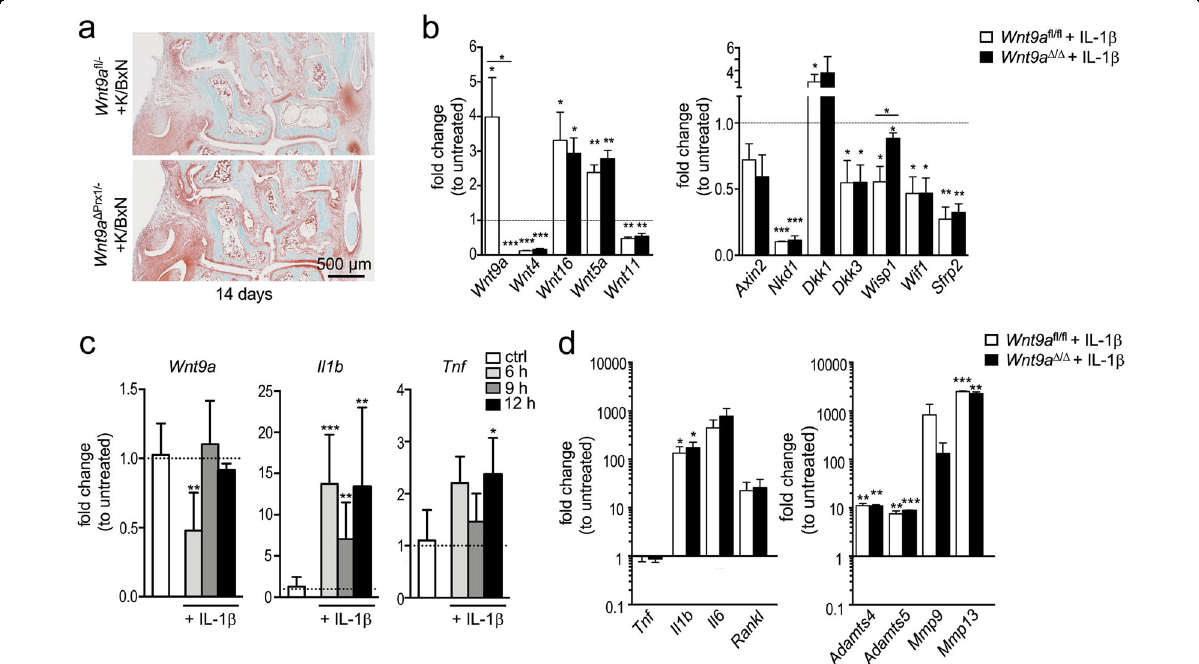
Fig. 6 Histological assessment of K/BxN-treated mice and alterations in gene expression levels in Wnt9a fl / fl and Wnt9a -de fi cient cells in response to IL-1 β treatment. a Representative images of Safranin O stained tarsal joint sections of the 14-day timepoint ( n = 3). b qPCR analysis of Wnt genes and Wnt pathway-related genes in Wnt9a f l/ fl and Wnt9a -de fi cient SFBs after treatment with recombinant murine IL-1 β . c qPCR analysis of short-term effects on the expression of Wnt9a, Il1b, and Tnf in response to stimulation with recombinant IL-1 β . d qPCR analysis of long-term effects on the expression of cytokines and catabolic enzymes in Wnt9a fl / fl (wild-type) and Wnt9a -de fi cient SFBs in response to stimulation with recombinant IL-1 β for 48